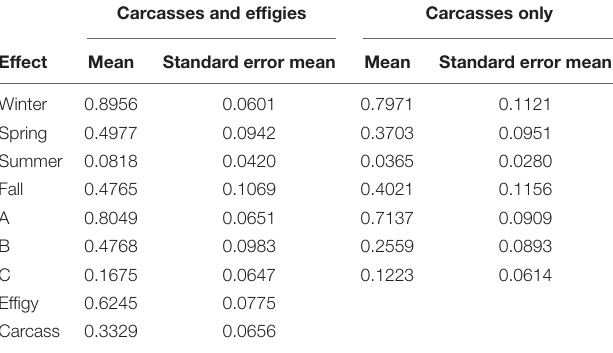
TABLE 3 | Estimated least square means of beaching probability by season [winter pre-season (January–February), spring peak (March–June), summer lull (July–September), and fall pulse (October–December)], deployment site (A, B, or C) and object type (effigy, n = 100 or carcass, n =